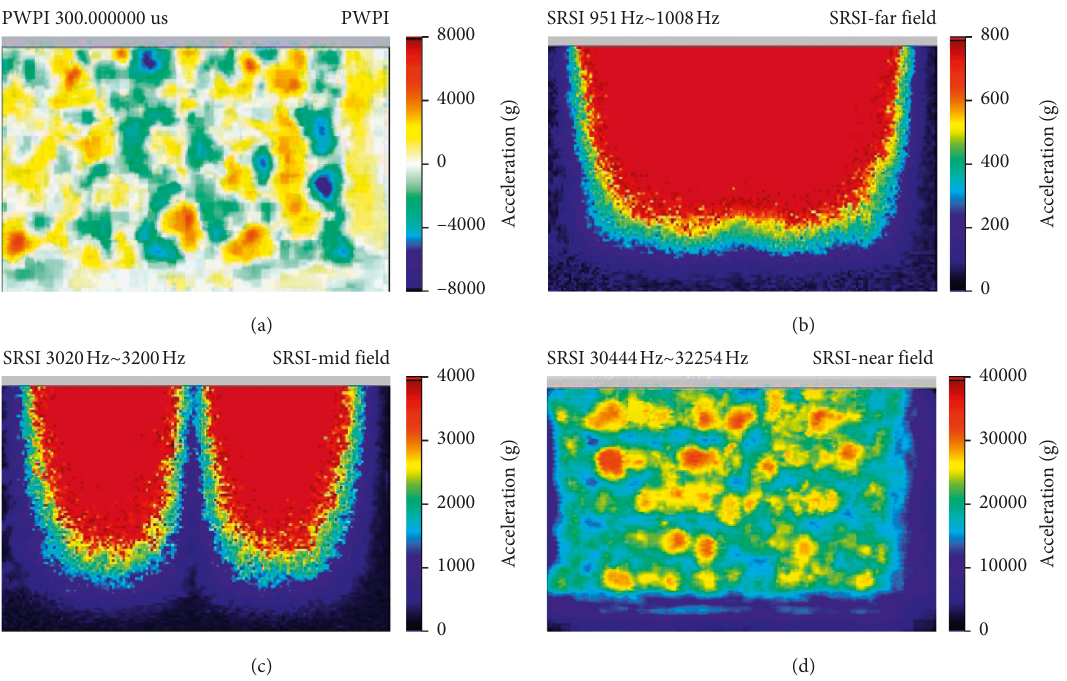
Figure 7: 1/2-inch explosive bolt-induced pyroshock propagation evaluation on the open-box-type tension joint: (a) PWPI at 300 μ s, (b) SRSI at 1kHz, (c) SRSI at 3kHz, and (d) SRSI at